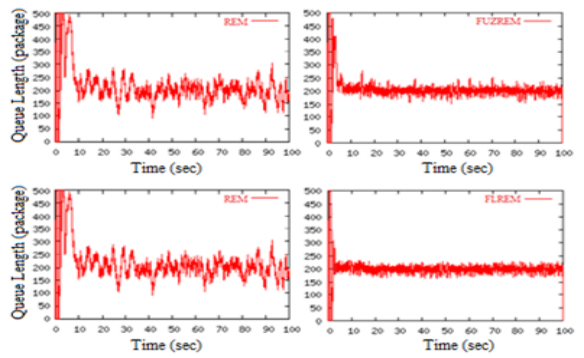
Figure 8. Control the queue of REM, FUZREM and FLREM